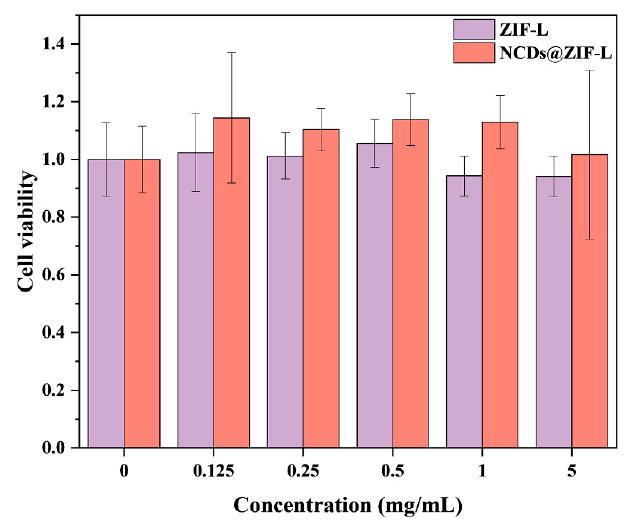
Figure 8. Toxicity results of ZIF-L and NCDs@ZIF-L on L929 cells obtained by CCK8 method experiments.